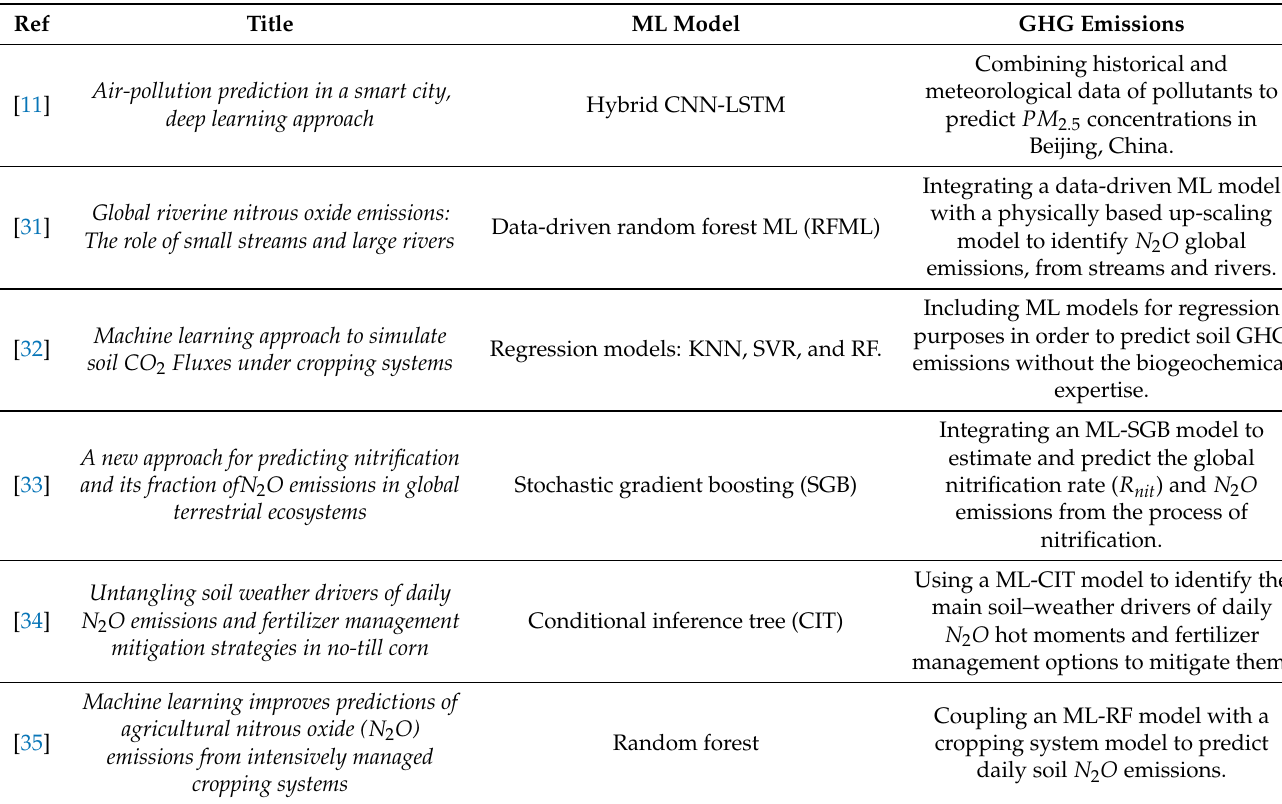
Figure 2. Direct and indirect pathways of N 2 O emissions from agricultural soil after nitrogen-based fertilizer applications. Table 1. Machine learning models used recently for predicting N 2 O and GHG